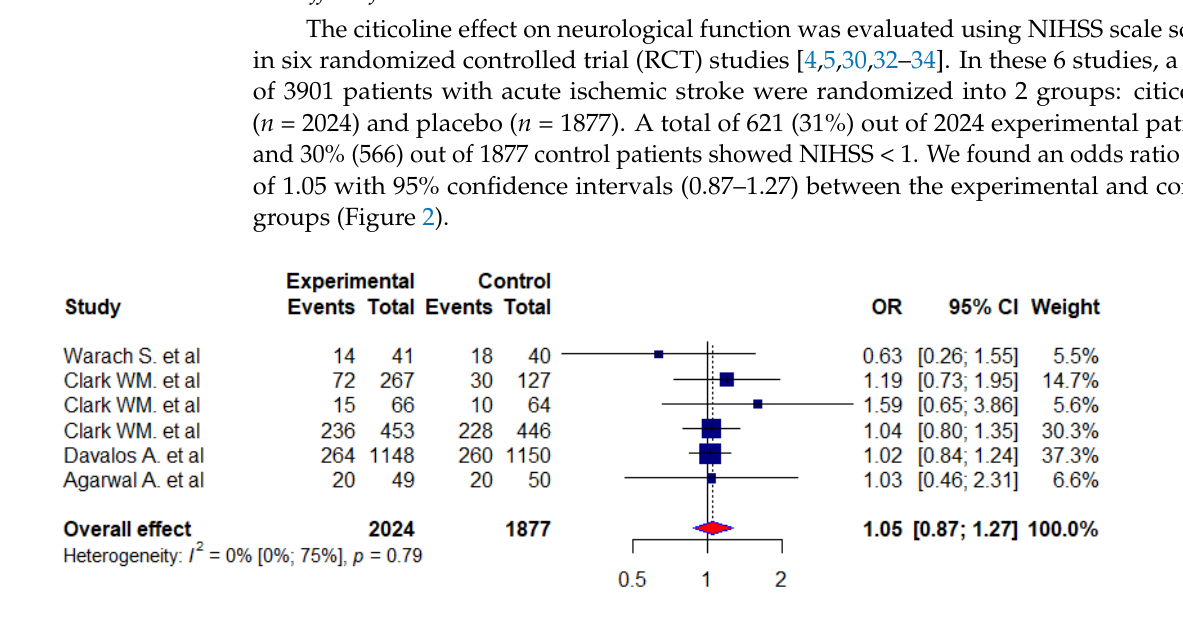
Figure 2. The forest plot of treatment effect of citicoline on neurological function (using NIHSS <